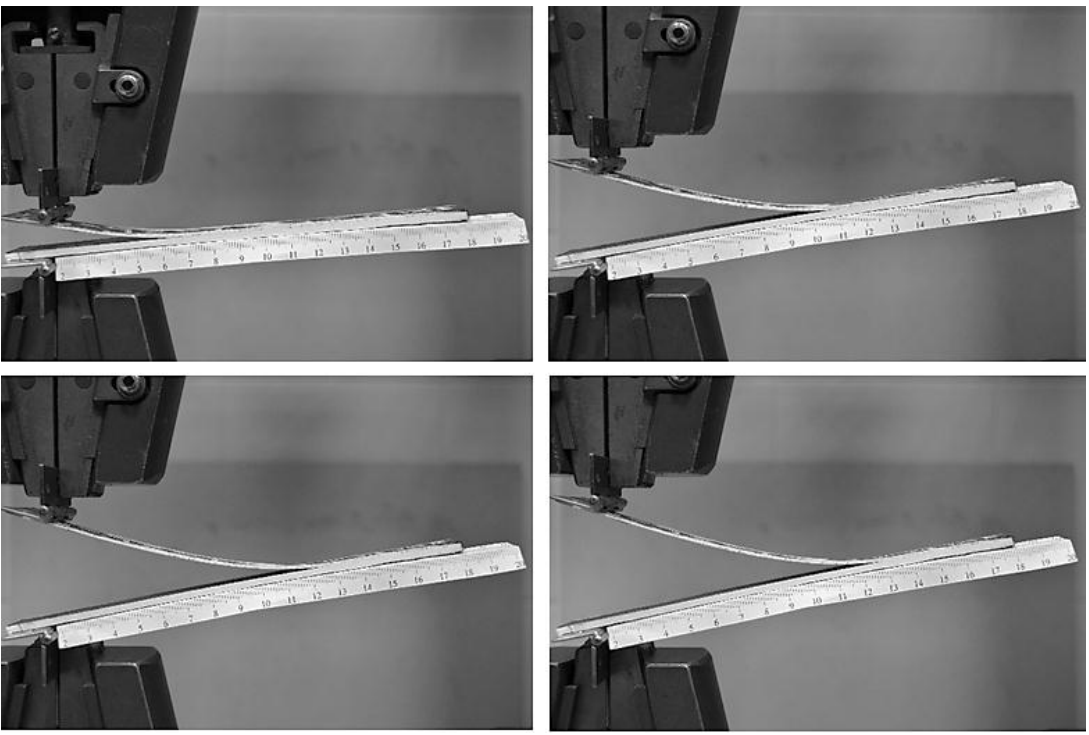
Figure 2. Visual analysis of the crack propagation.